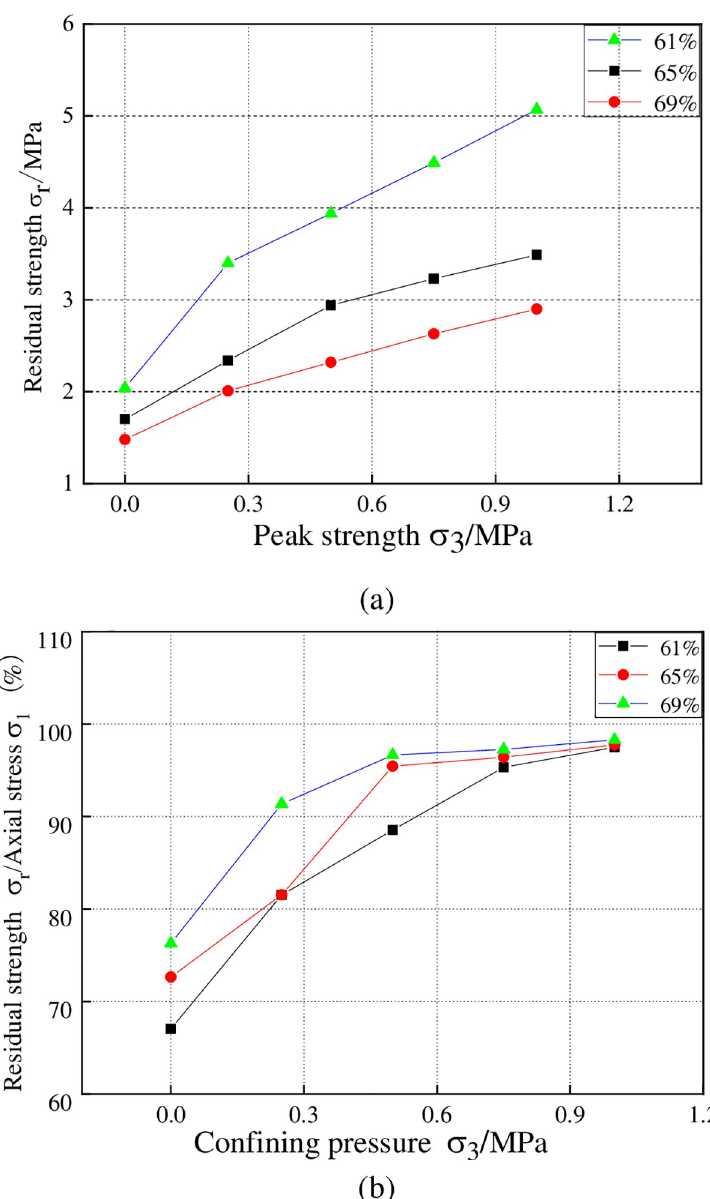
Fig 6. The change curve of residual strength under different water contents. (a)The change curve of residual strength versus confining pressure, (b) The change curve of residual strength proportion.